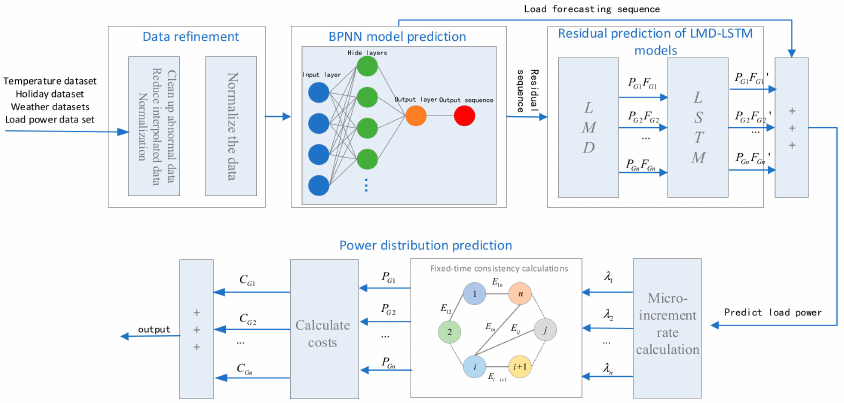
Figure 1. Schematic diagram of the economic dispatch framework for short-term load forecasting.